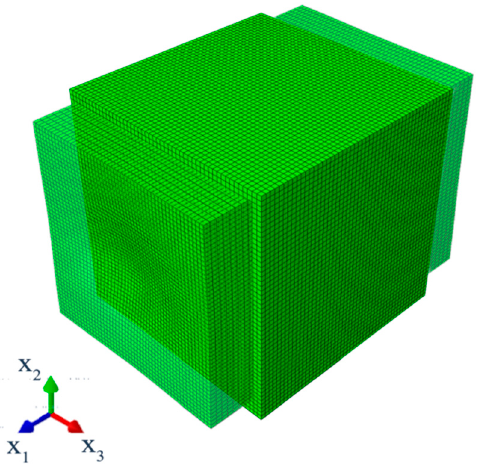
Figure 3. Discretization and deformation map of the composite RVE.